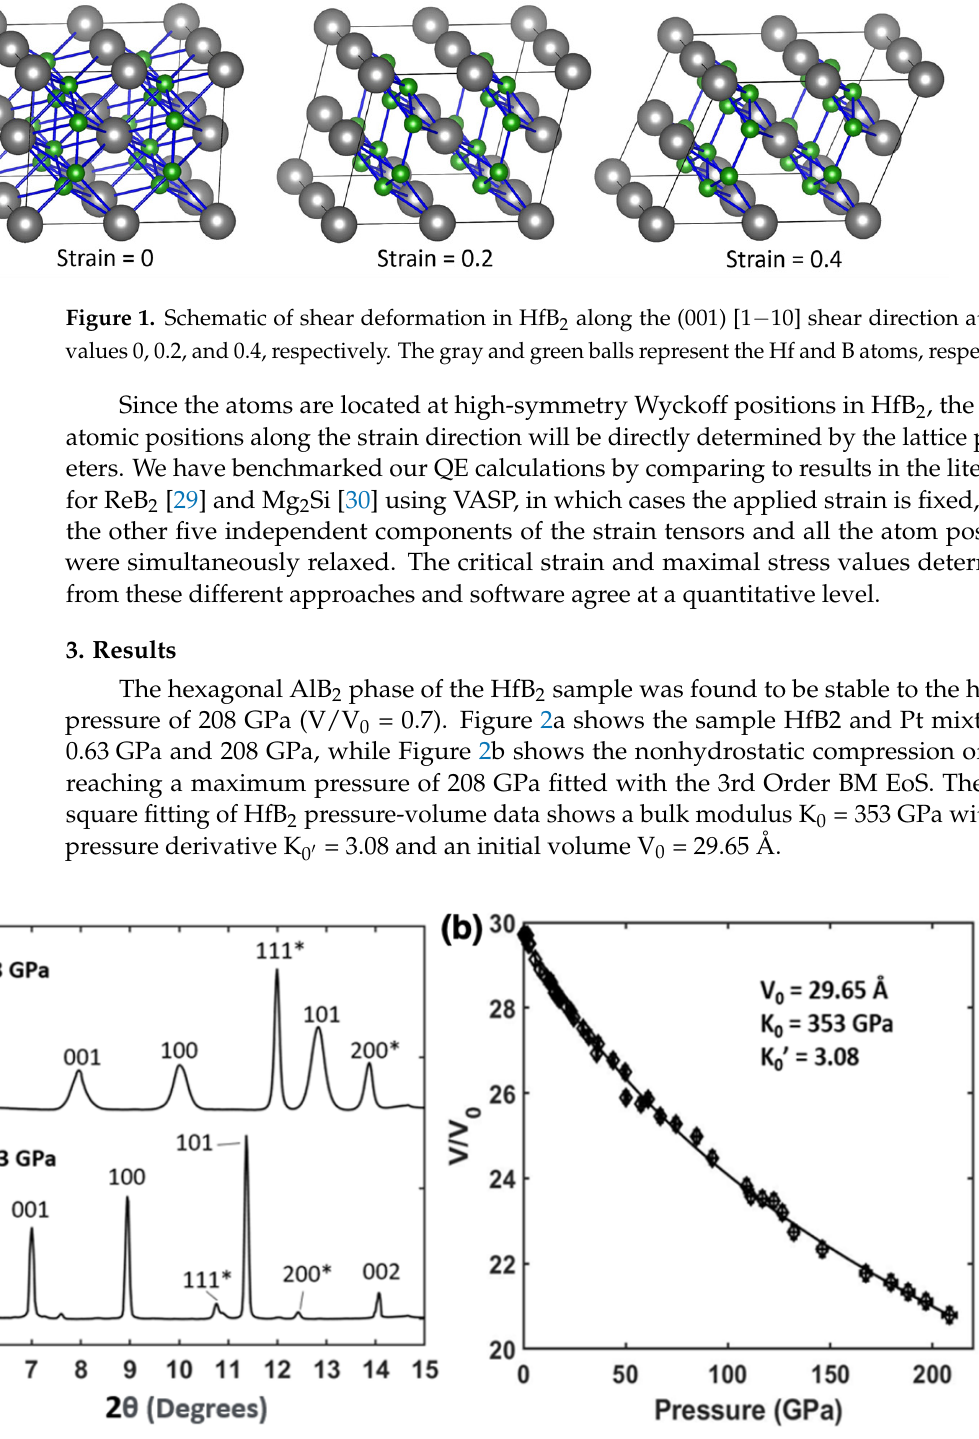
Figure 1. Schematic of shear deformation in HfB 2 along the (001) [1 − 10] shear direction at strain values 0, 0.2, and 0.4, respectively. The gray and green balls represent the Hf and B atoms, respec- tively.